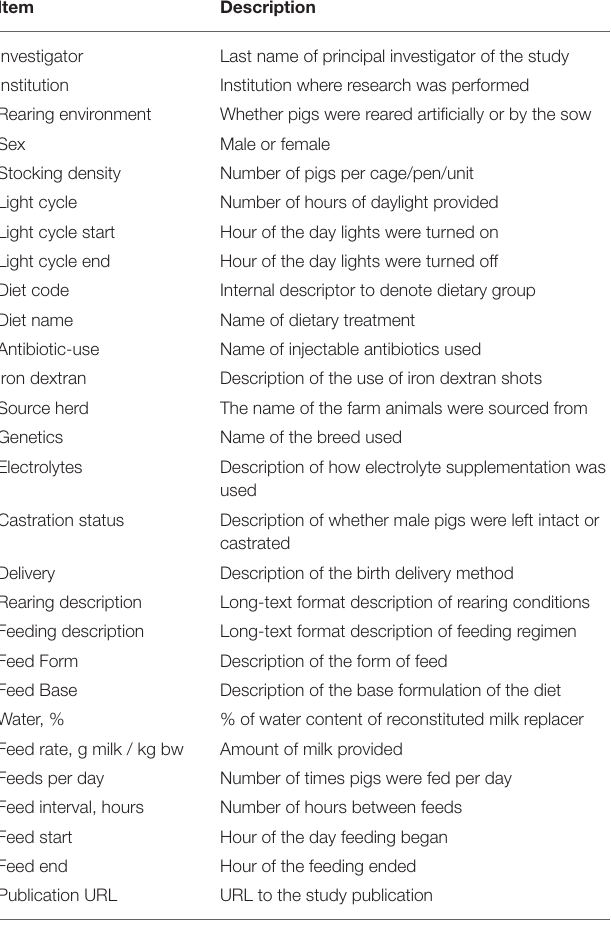
TABLE 2 | Sample metadata captured a